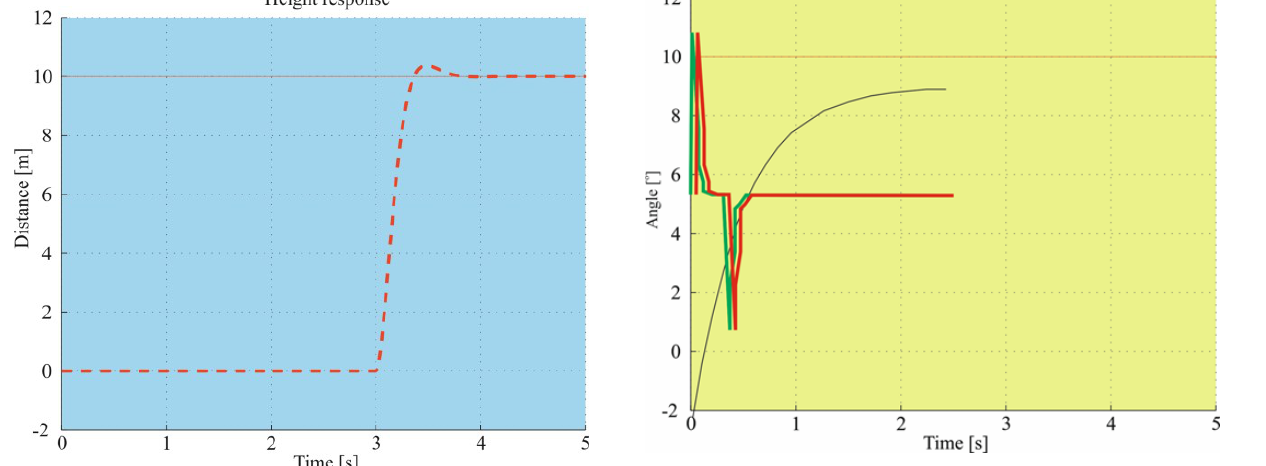
Fig. 4. Flight altitude dependence on time (PID response)